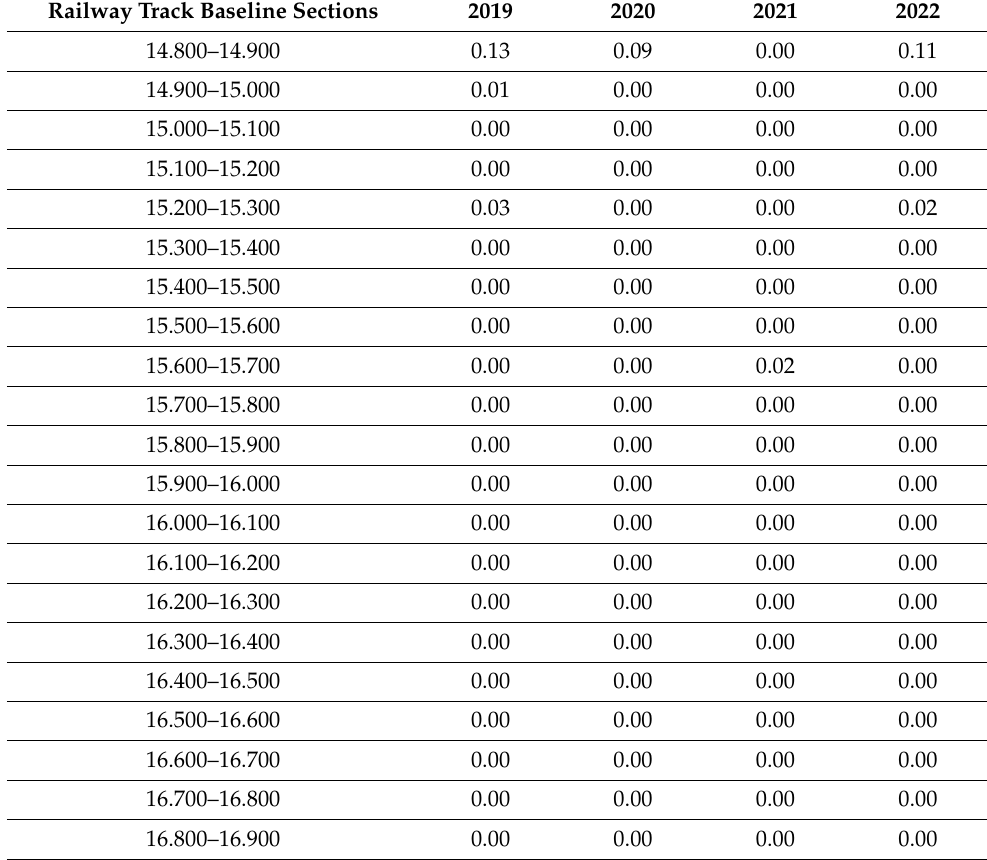
Table A8. Estimates of the railway track condition—relative D 5 object No. R 144_1. Railway Track Baseline